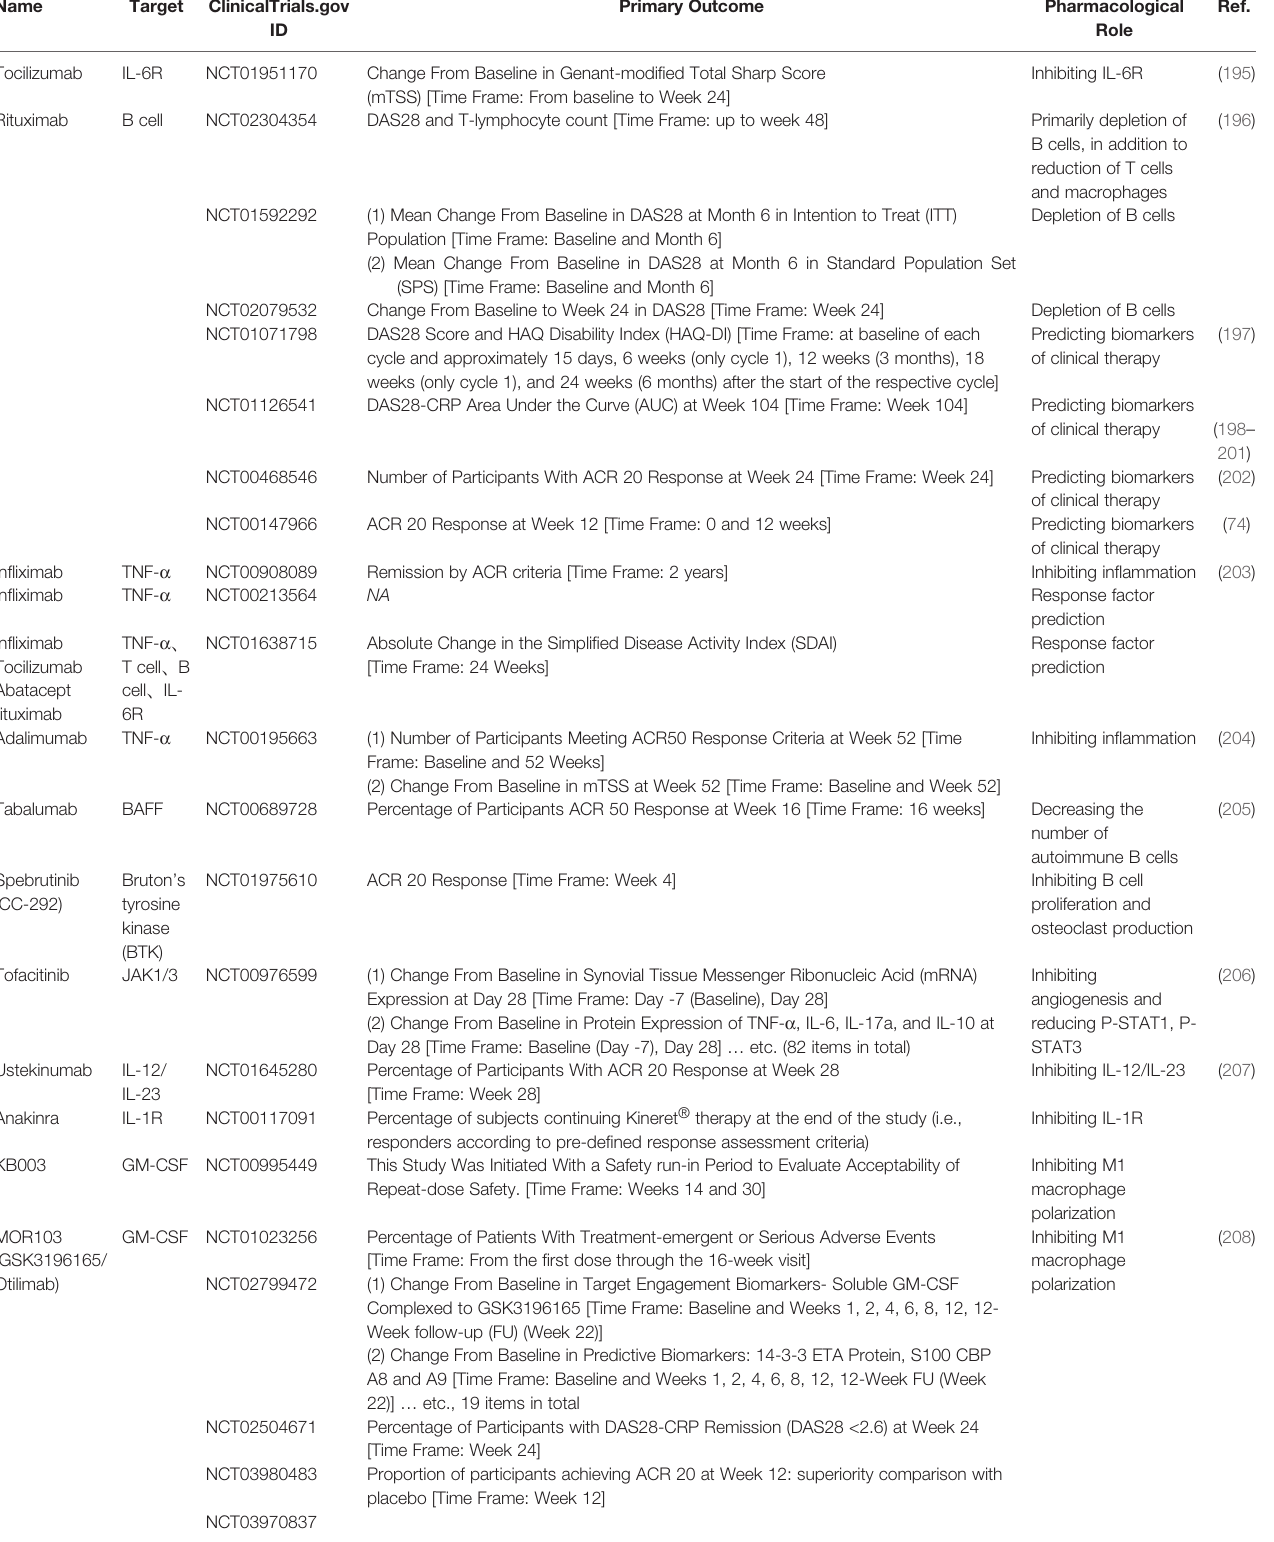
TABLE 2 | RA-related biologic therapy and clinical trials.